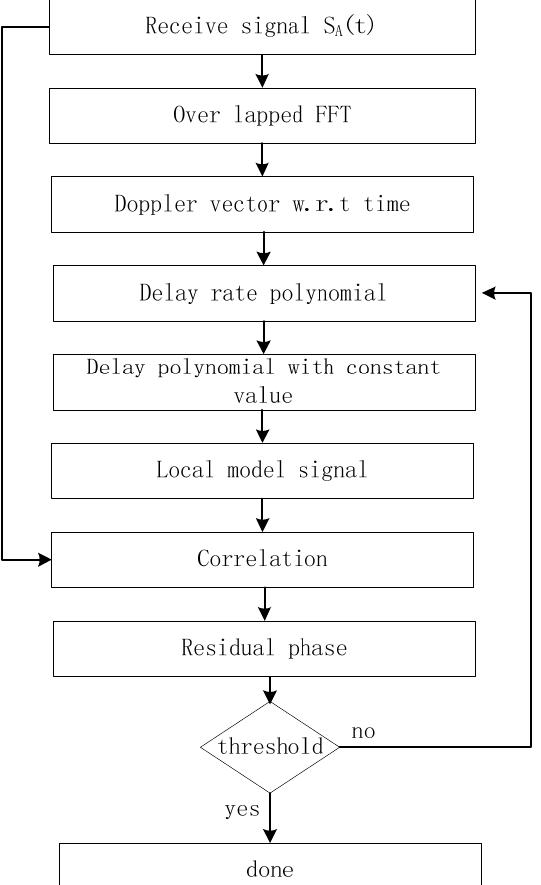
Figure 3. Flow scheme of the algorithm.